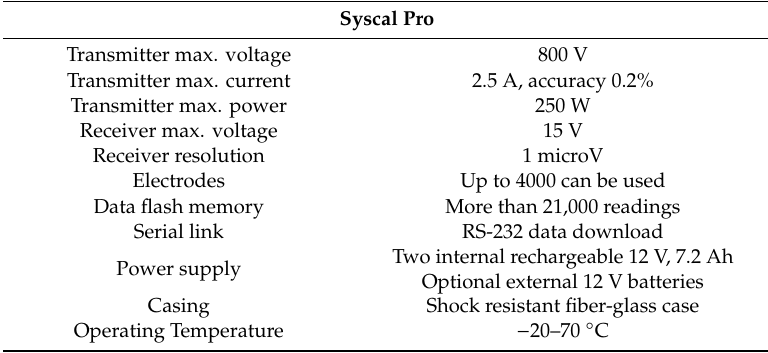
Table A2. Specifications of Syscal Pro device.